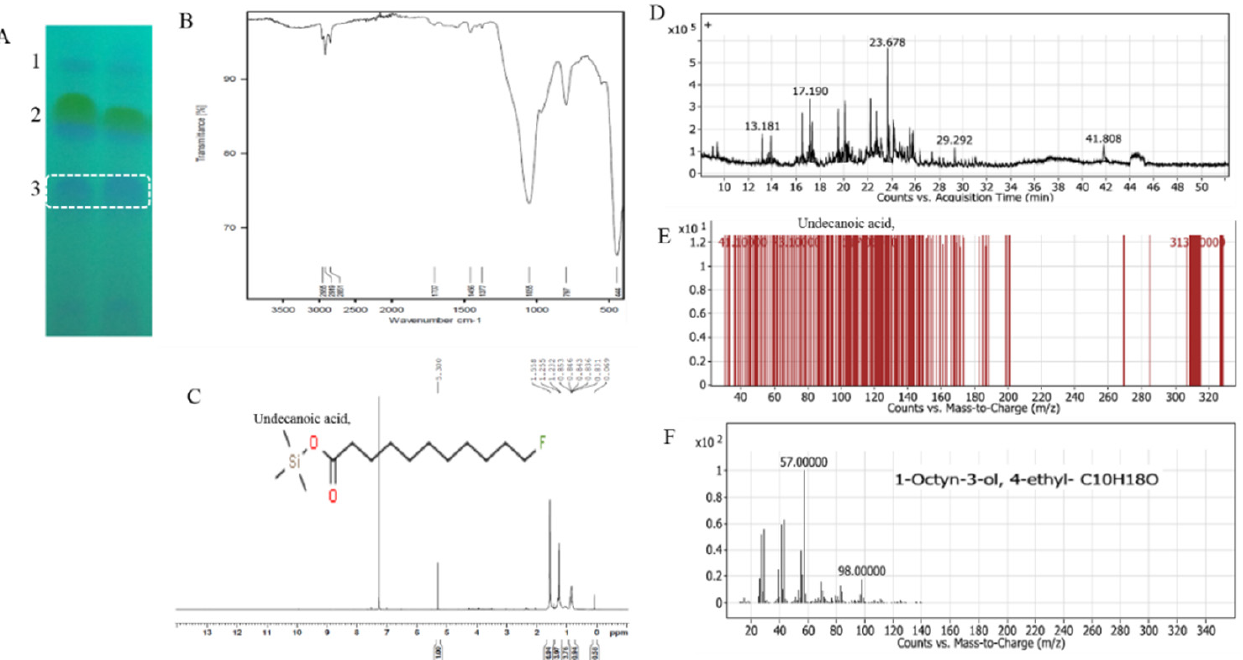
Figure 7. TLC and GC-MS analyses of the potent putative tyrosinase inhibitors (Spot# 3) of DCM extract of A. flavus. The potent spots #3 of DCM extract of A. flavus was fractionated by TLC, and the visualized spots by UV-illumination were scarped-off and their inhibitory activity for tyrosinase was assayed by the standard assay. TLC chromatogram of the DCM extract of A. flavus ( A ), the FT-IR spectra ( B ), and HNMR spectra ( C ) of the putative spots #3. The GC-MS chromatogram of the spots #3 ( D ), the resolving spectra and putative compounds from the LC-MS analyses ( E , F ).